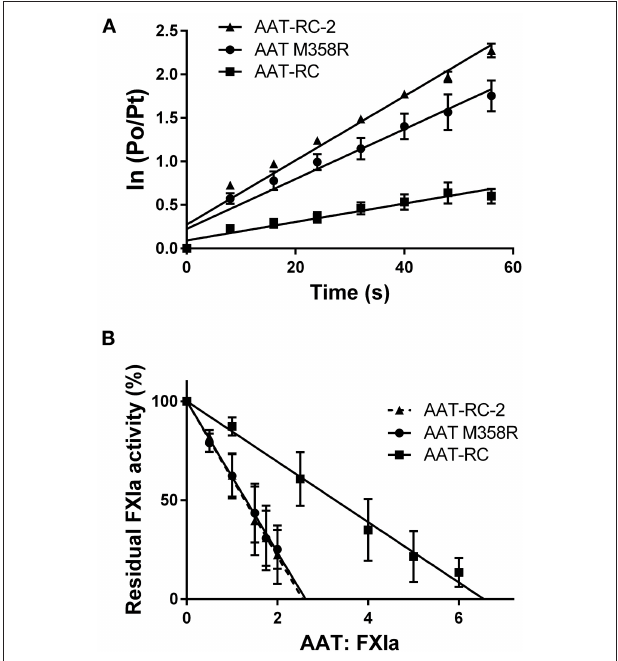
FIGURE 1 | Kinetic parameters of AAT variants. (A) The natural logarithm of the ratio of the initial protease (FXIa) activity ( P 0 ) to the residual activity at time t ( P t ) vs. the time in seconds [time (s)]. Points are the mean ± SD of five determinations; lines are lines of best fit determined by linear regression. (B) The residual FXIa activity as a percentage of initial activity after incubation of AAT variants with differing molar ratios of FXIa for 2h. Points are the mean of four (AAT M358R), six (AAT-RC-2), or eight (AAT-RC) separate experiments; lines are lines of best fit determined by linear regression. Note that the regression line for AAT-RC-2 is dashed to distinguish it from its superimposed neighbor, the line for AAT M358R. TABLE 3 | Kinetic parameters for AAT-RC-2 and AAT M358R with various proteases. Protease